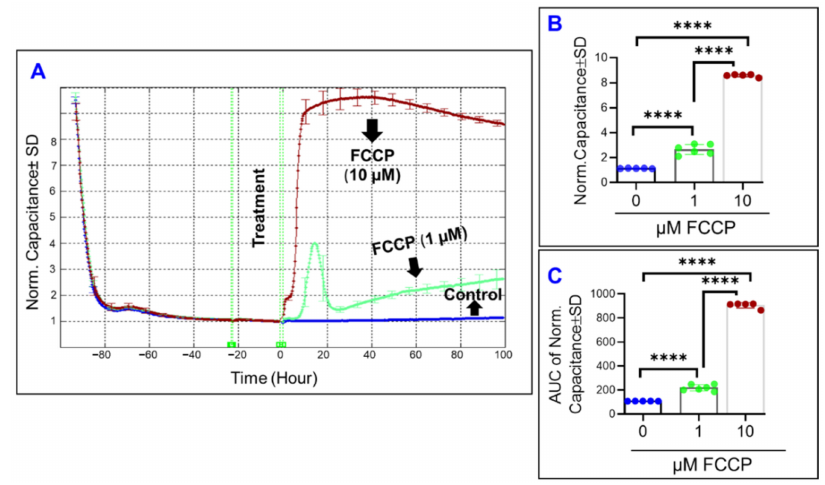
Figure 2. Real-time spreading of ARPE-19 cells in a state of OxPhos uncoupling. ( A ) Normalized capacitance across ARPE-19 cells vs. time, measured at an AC current frequency of 64,000 Hz. Treatments were applied at time T = 0. ARPE-19 cell groups were control, FCCP 1 µ M treatment, and FCCP 10 µ M treatment. Capacitance was measured from time of placement onto electrode to 100 h after treatment application, and capacitance was normalized to T = 0. ( B ) Bar chart representation of the normalized capacitance of each of the cell groups at time T = 100 h, the experiment’s endpoint. ( C ) Bar chart representation of the area under the normalized capacitance curve of the ARPE-19 cell groups for the interval T = 0–100 h. Abbreviations: AUC, area under the curve; Norm, normalized. Data shown are the mean ± SD of 5–6 independent biological replicates per group. p values are **** p ≤ 0.0001.